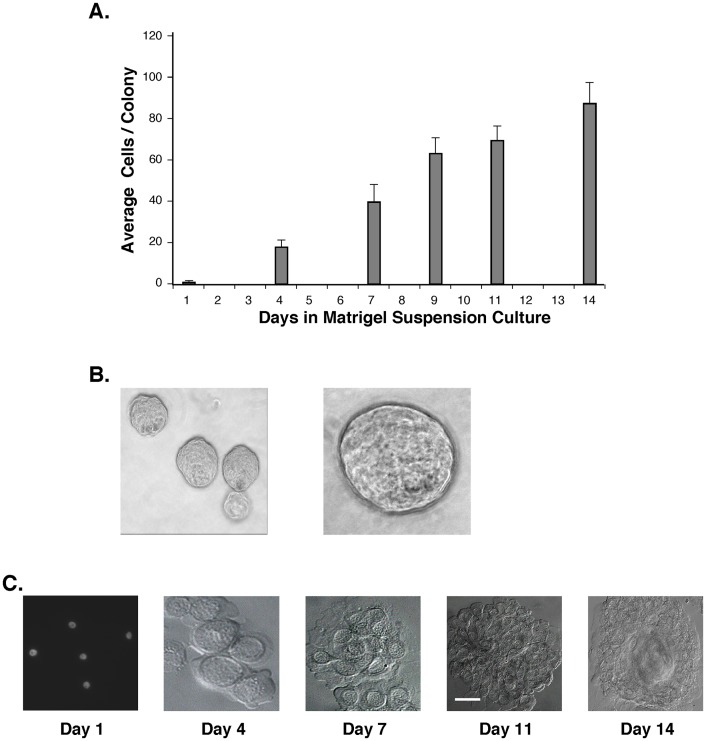
High-frequency self-renewal of PrCa cell spheroids in Matrigel suspension cultures.Low passage, adherent PrCa cells (#76, tr 2) were trypsinized and suspended in Matrigel in medium 6+++. Suspension cultures were grown for 14 days and spheres of replicate cultures were harvested on days 1, 4, 7, 9, 11 and 14. Cultures were digested with dispase, pelleted on microscope slides by cytocentrifugation and fixed with methanol. (A) The size of the spheres was determined by counting the cells of >200 stained spheres at each time-point. (B) Early and late time-point spheres were photographed under an inverted microscope. (C) Representative harvested spheres growing 1, 4, 7, 11 and 14 days in Matrigel cultures, and deposited on microscope slides for imaging, counting and antibody staining.